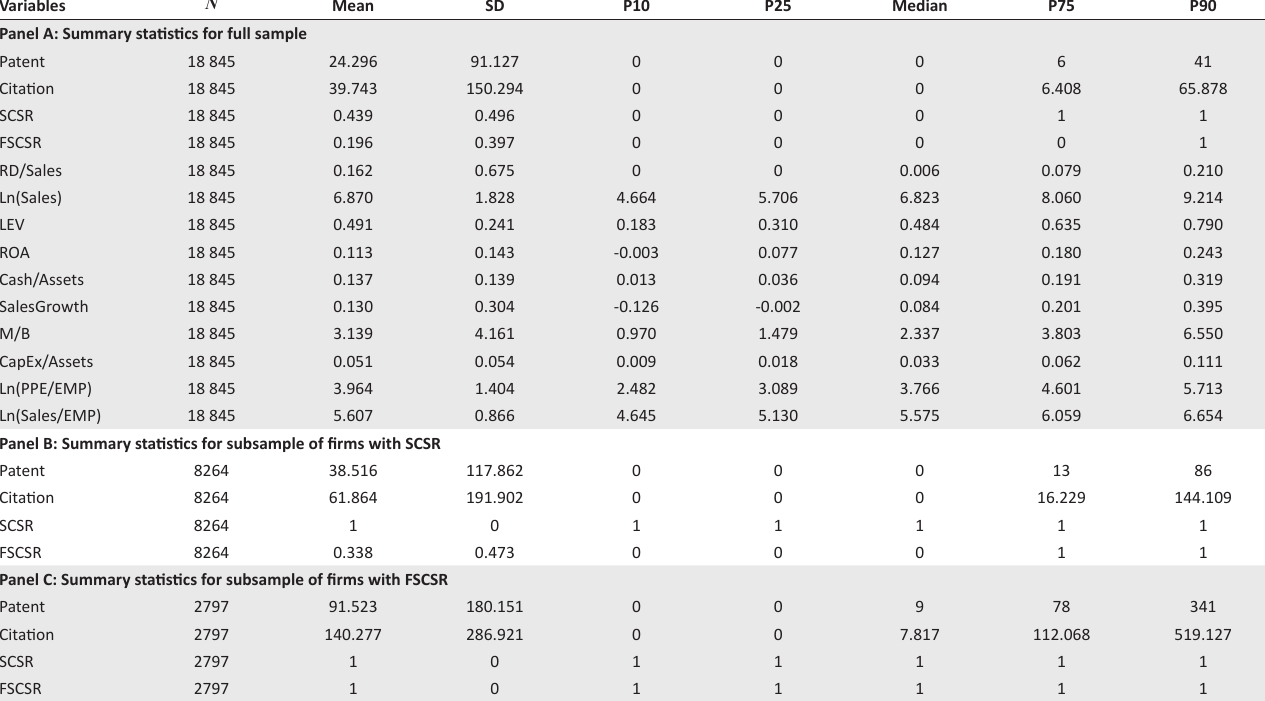
TABLE 1: Summary statistics. Panel A: Summary statistics for full sample